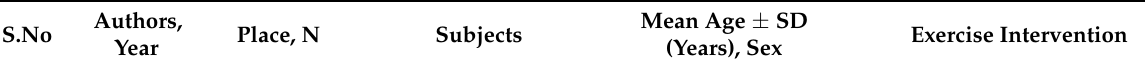
Table 1. Effect of exercise on subjects with cancer and baseline measurement of sarcopenia.